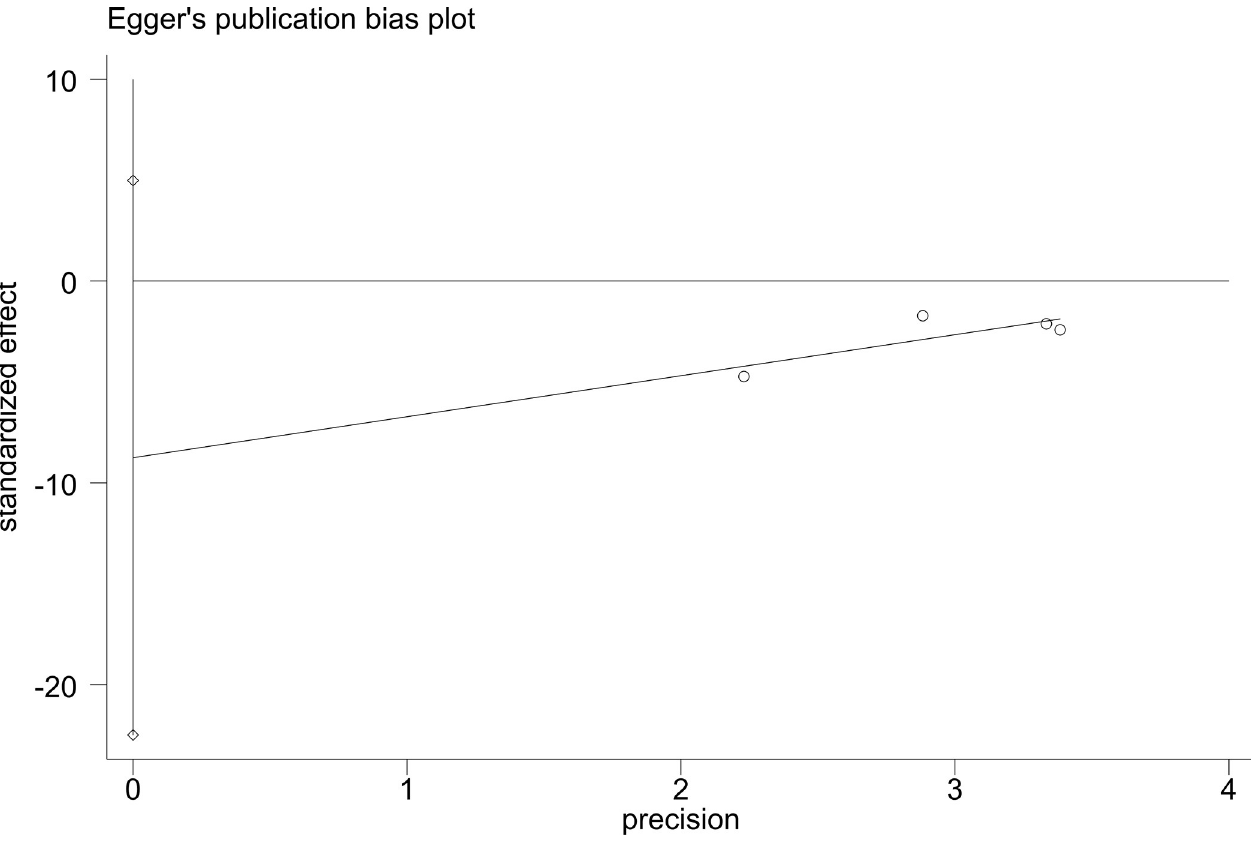
Fig 8. Egger’s test for DCP